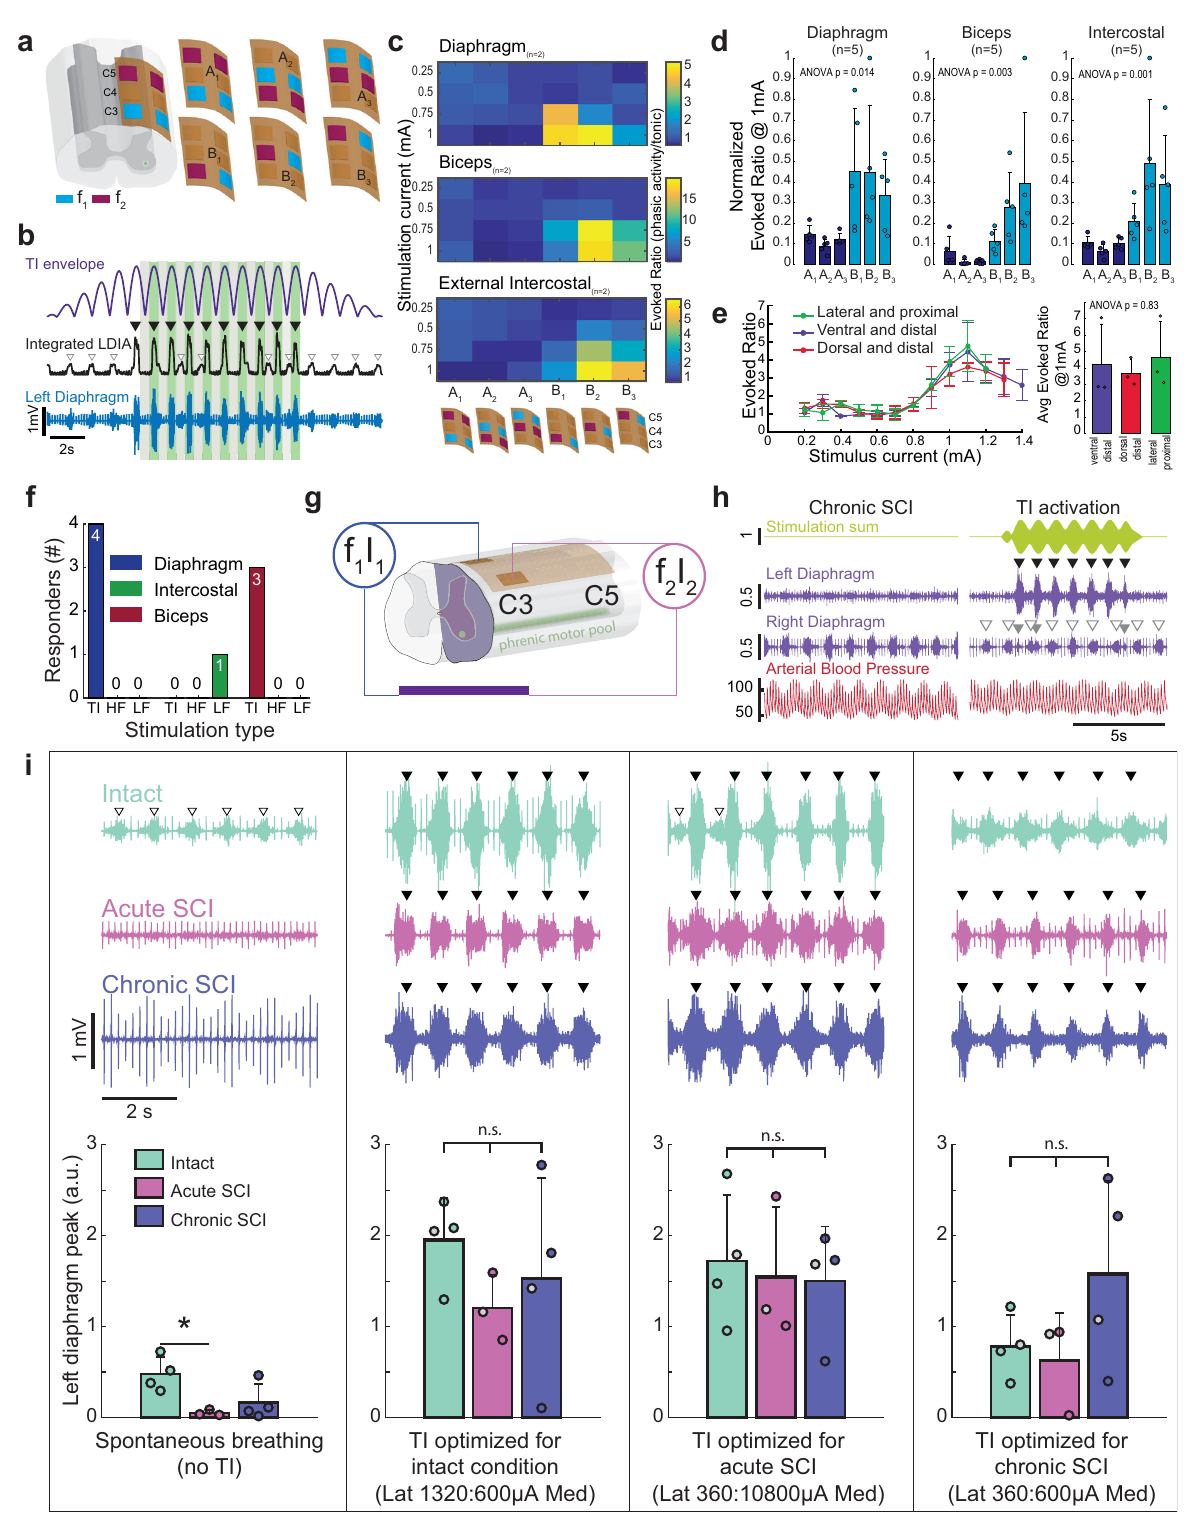
evidenced by large EMG bursts occurring in phase with the TI beat frequency (Fig. 3h, right panel). We systematically evaluated this response after acute or chronic (10 month) spinal cord injury in separate experimental cohorts. The C2Hx lesion immediately eliminated spontaneous EMG activity in the ipsilateral diaphragm in the acutely injured rats and caused a substantial reduction in spontaneous EMG output in those with chronic injury (Fig. 3i). COMMUNICATIONS BIOLOGY| (2021) 4:107